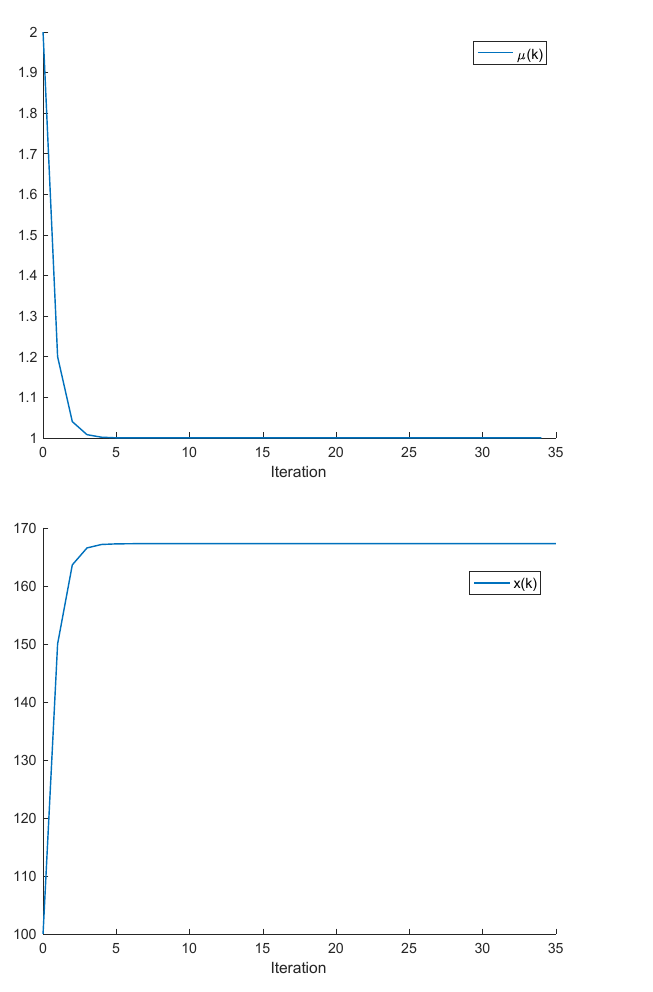
Figure 2. Evolution of µ ( k ) and x ( k ) with iteration in Example 2 when µ ( k ) converges to unity in finite time.